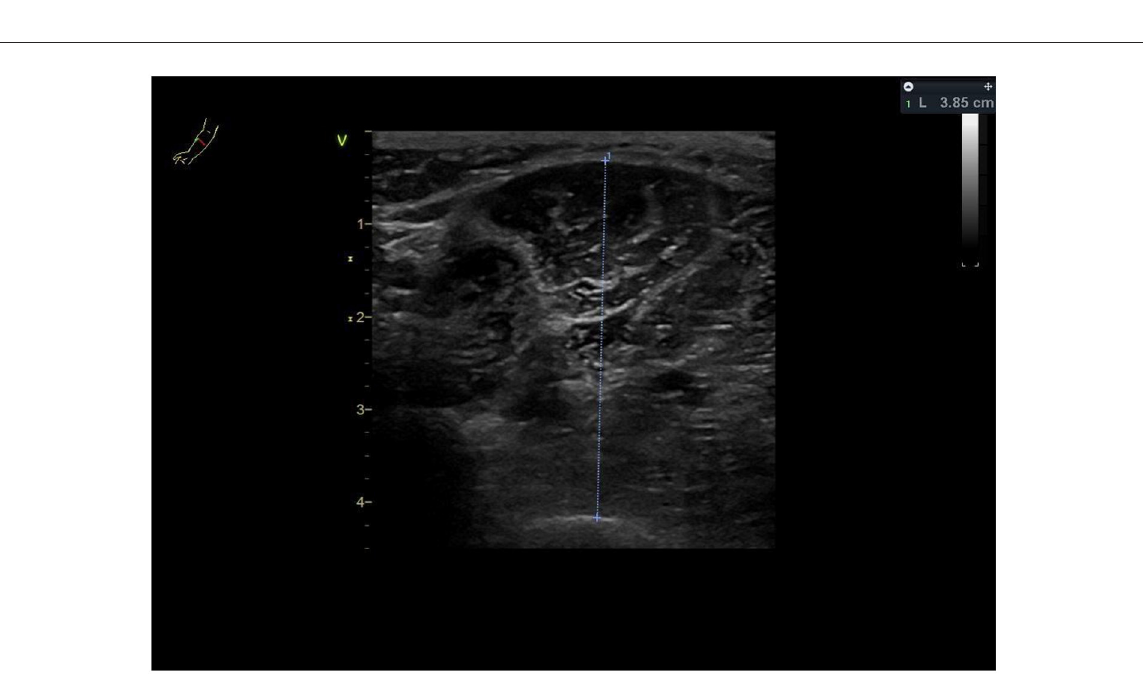
FIGURE3 Muscle thickness ulna right forearm (here